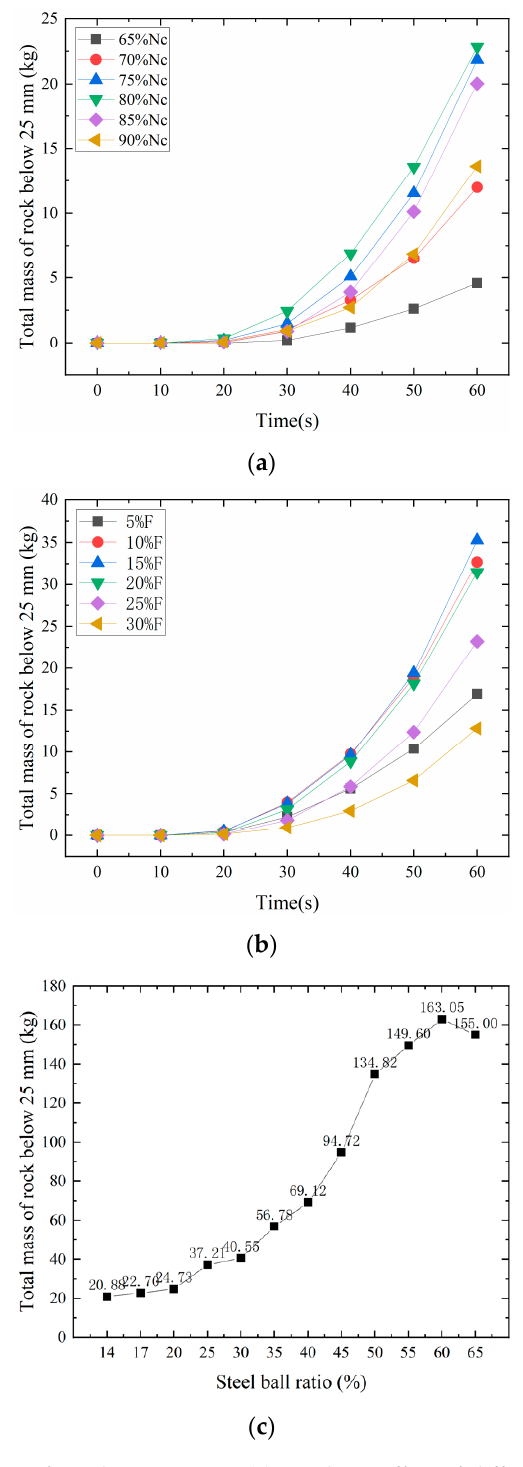
Figure 6. Breakage effect of single parameter. ( a ) Breakage effect of different mill speed ratio; ( b ) Breakage effect of different fill level ratio; ( c ) Breakage effect of different steel ball ratio.